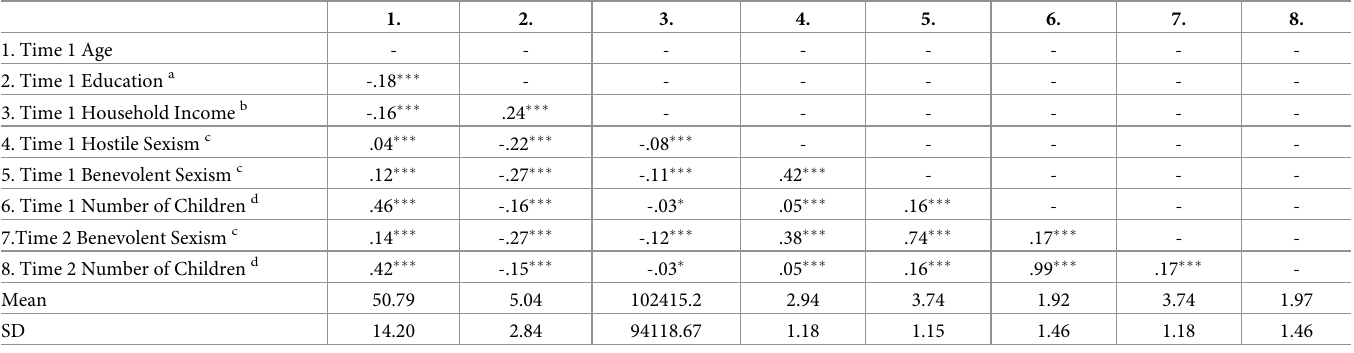
Table 1. Descriptive statistics and bivariate correlations.